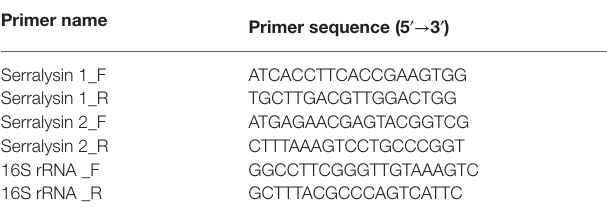
TABLE 1 | Primer sets used for qRT-PCR in this